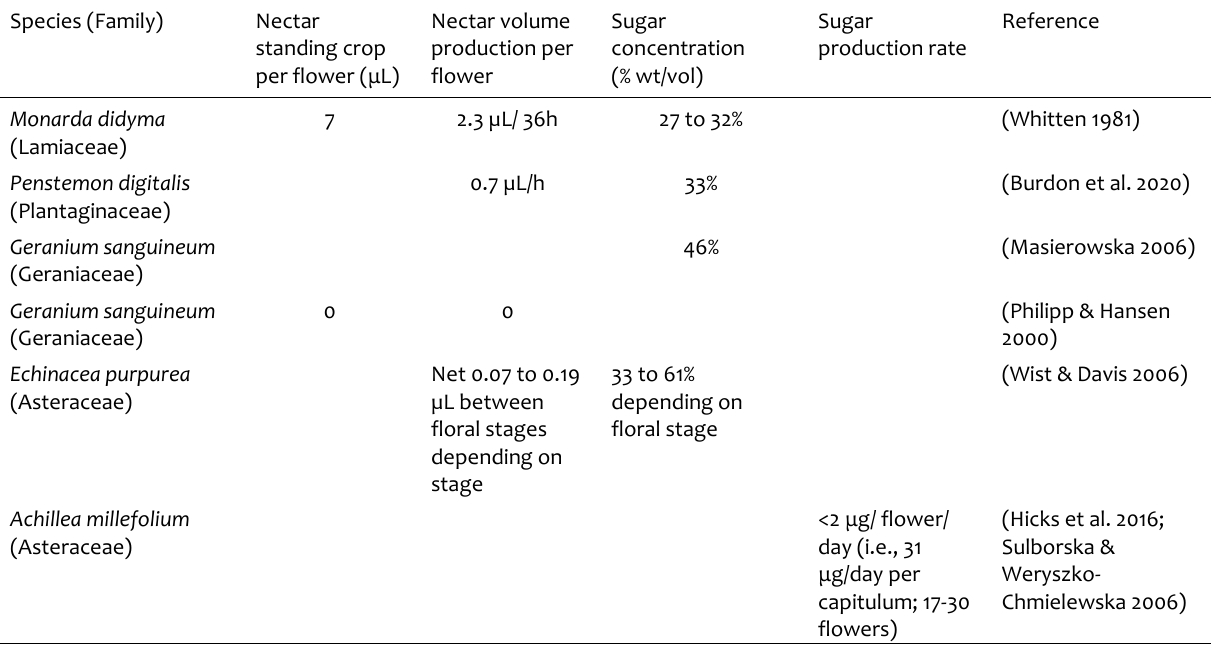
Table 1: Nectar attributes for five plant species included in study by Finkelstein et al (2022). They added 15µL of artificial nectar with concentration 35% wt/vol (i.e., 0.35 mg/µL) to individual flowers three times per day. This amounts to an additional 45 µL of artificial nectar per flower per day, containing 15.75 x 10 3 µg sugar. Concentration of added nectar is within observed range for study species, but added nectar volume and nectar sugar greatly exceed observed